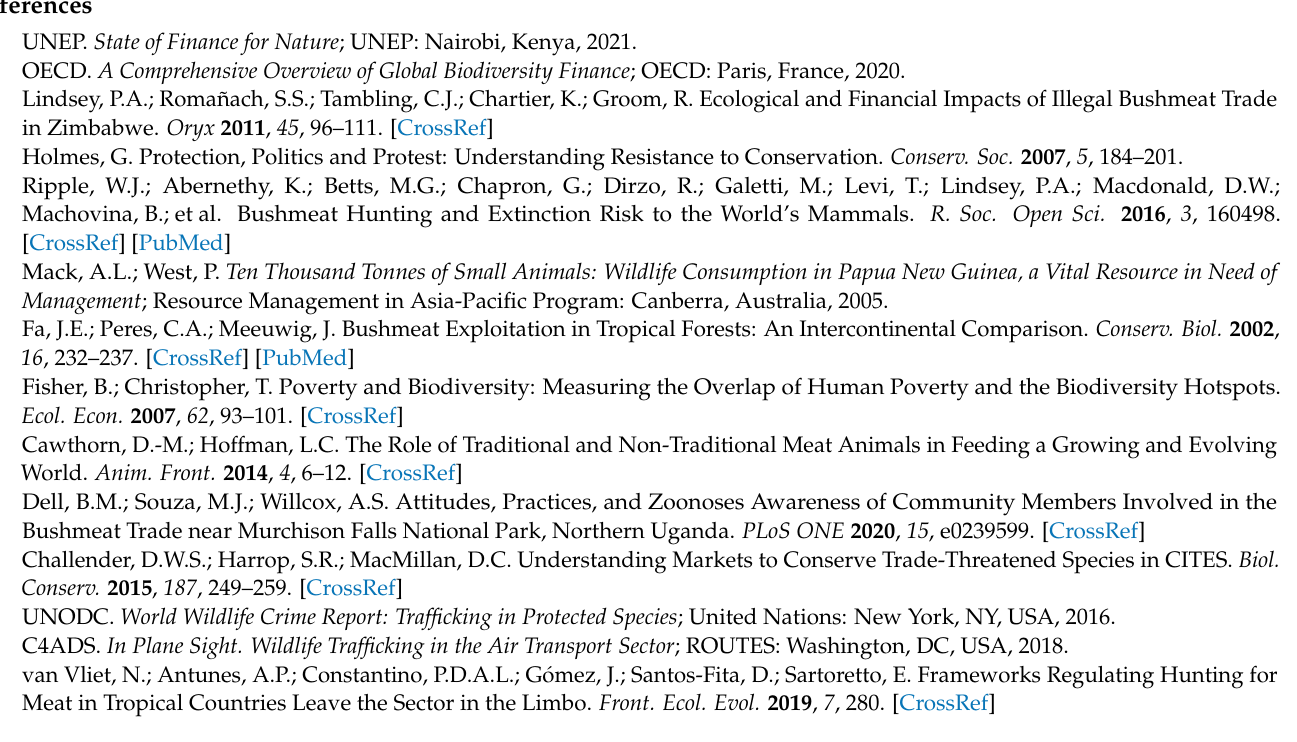
Figure A9. Residency locations of domestic animal meat buyers and locations where they acquire each type of meat in Sebitoli area, Kibale National Park, Uganda (May–December 2016).